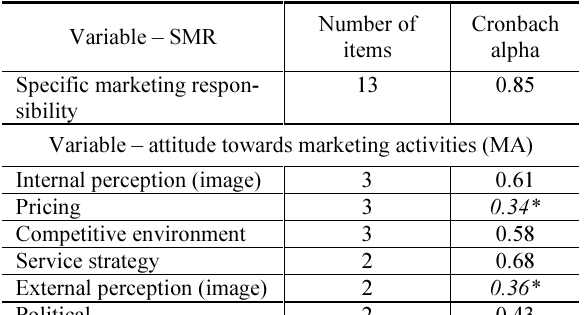
Table 3. Reliability coefficients for variables related to marketing